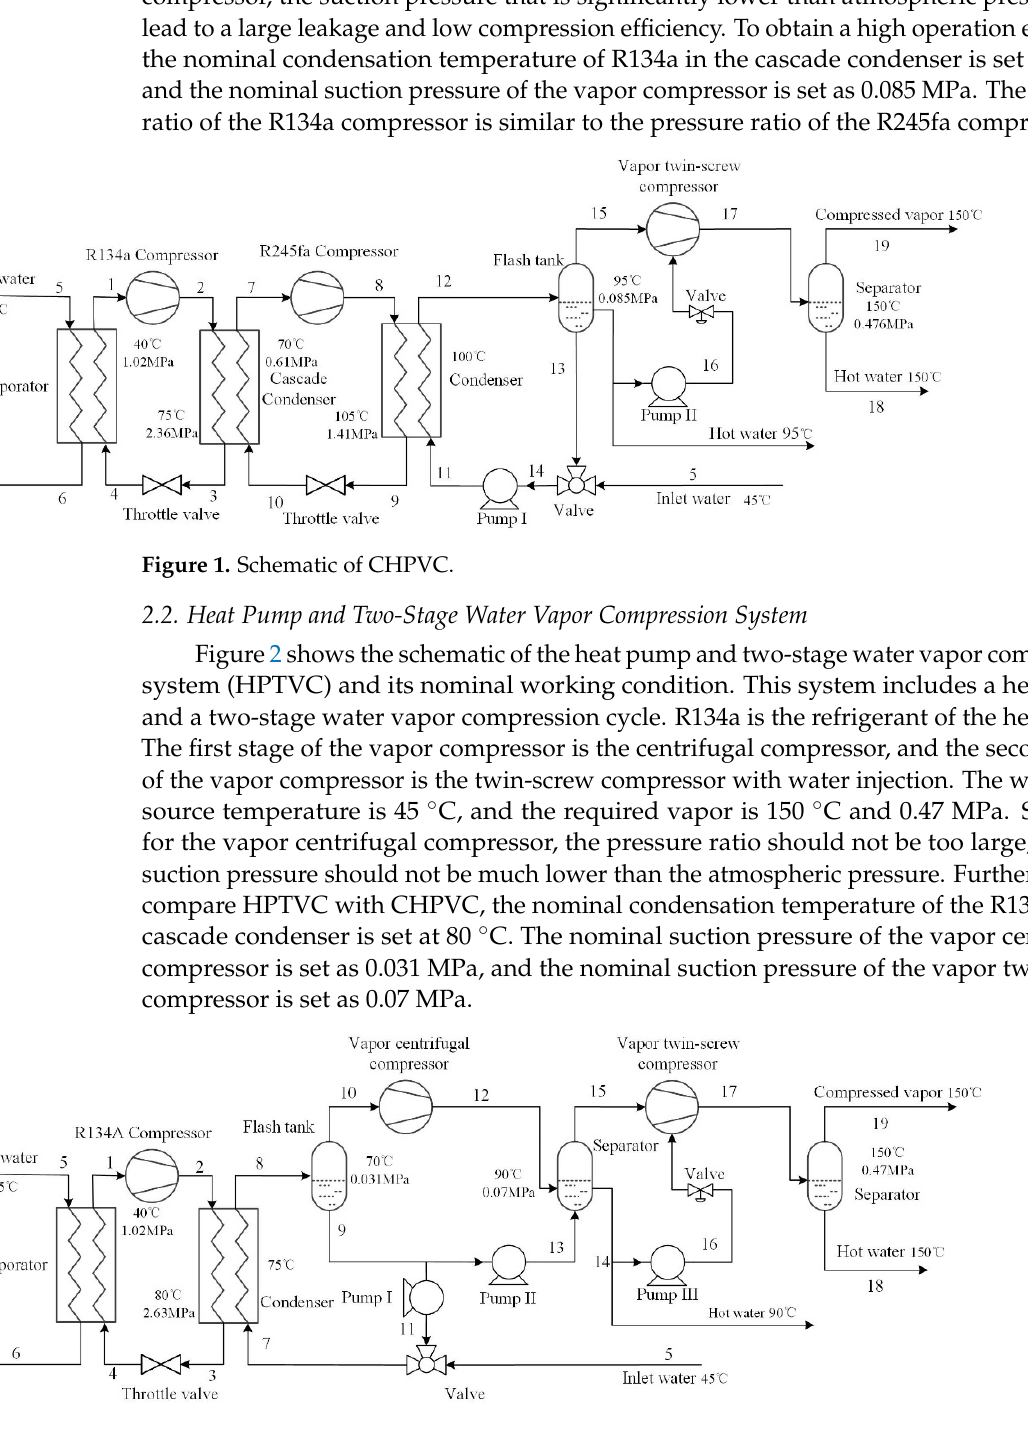
Figure 2. Schematic of HPTVC.